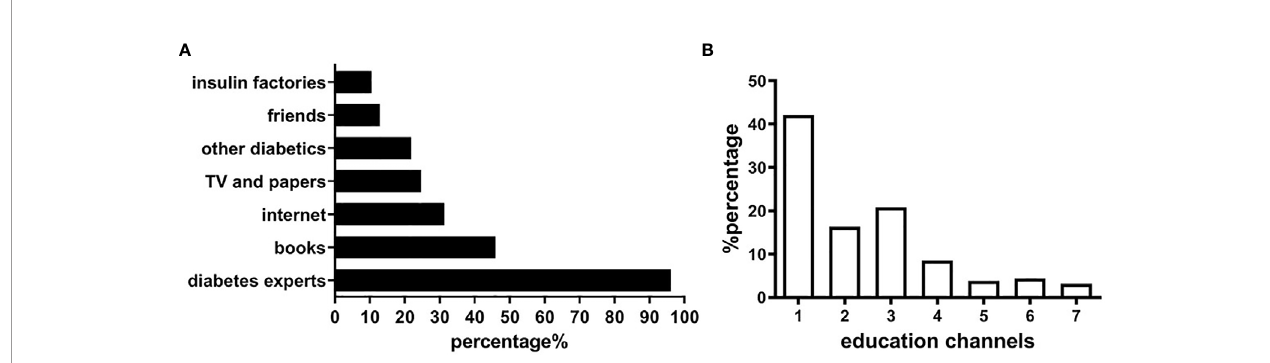
FIGURE 3 | Diabetes education in patients and guardians. (A) Relevant sources for diabetes education. (B) Education channels of obtaining diabetes